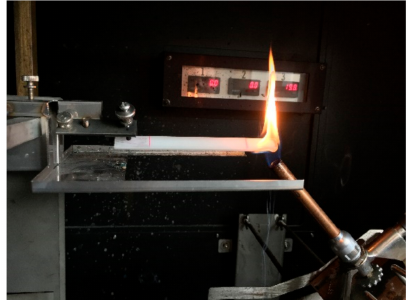
Figure 1. Flame treatment in accordance with UL 94